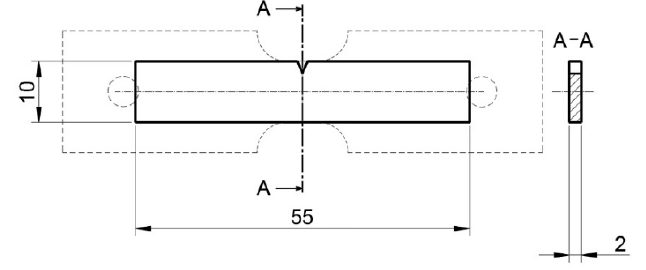
Figure 9. Sample with a reduced thickness of 2 mm used to measure the Charpy pendulum impact test (unit: mm).